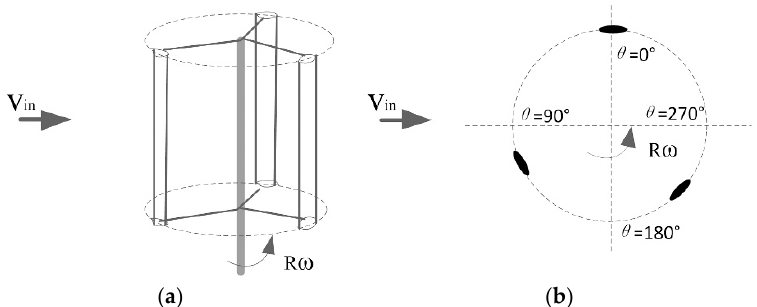
Figure 1. Schematic of an H-type Vertical Axis Wind Turbines (H-VAWT): ( a ) 3D schematic; and ( b ) 2D cross-section. The rotor of the H-VAWT turns counterclockwise; the azimuth angle θ is defined to help describe the active conditions of an H-VAWT. R is the radius of the rotor in units of mm. ω is the rotation angular velocity of the rotor in units of rad/s.